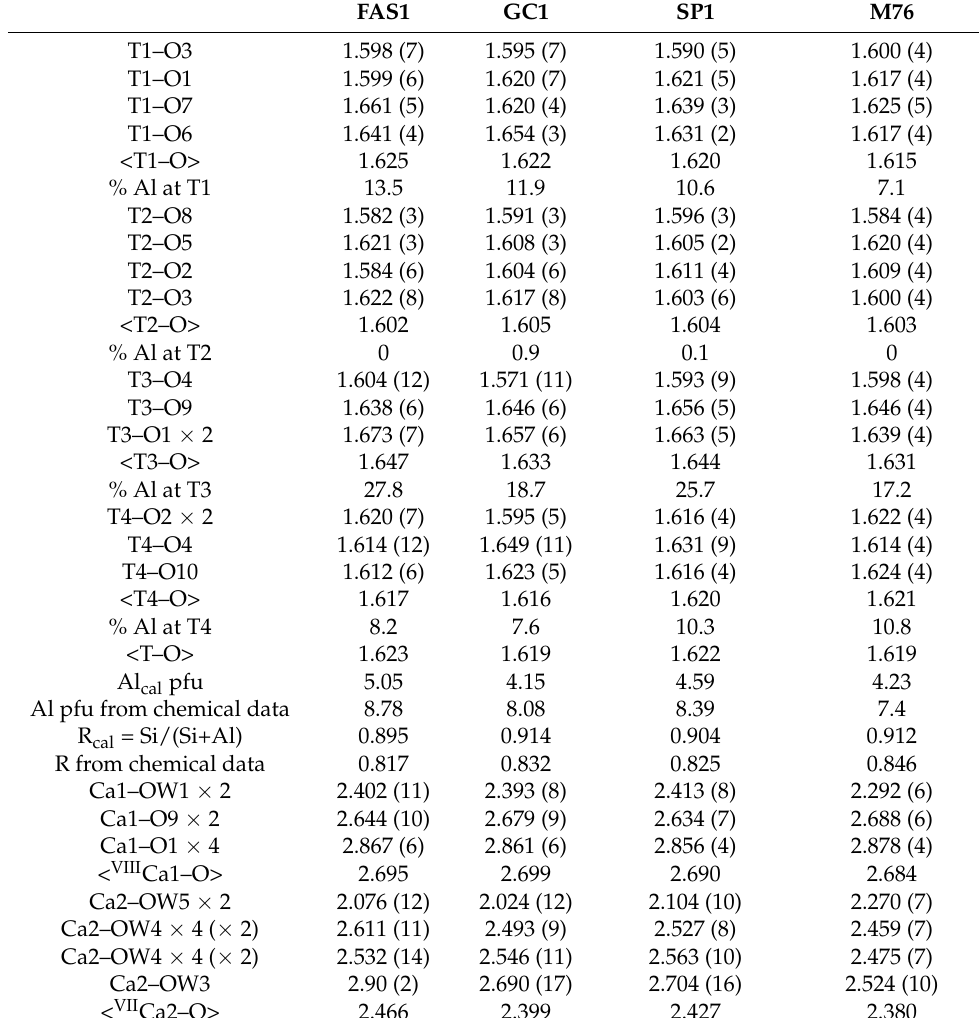
Table 8. Relevant bond distances (Å). The Al population at the various tetrahedral sites T (% Al) and the corresponding R = Si/(Si+Al) were calculated using the equation of Jones [82]. Data of Mortier et al. [81] are reported for comparison (M76). Due to short OW4–OW4 contacts, only half of the Ca2–OW4 distances are effectively